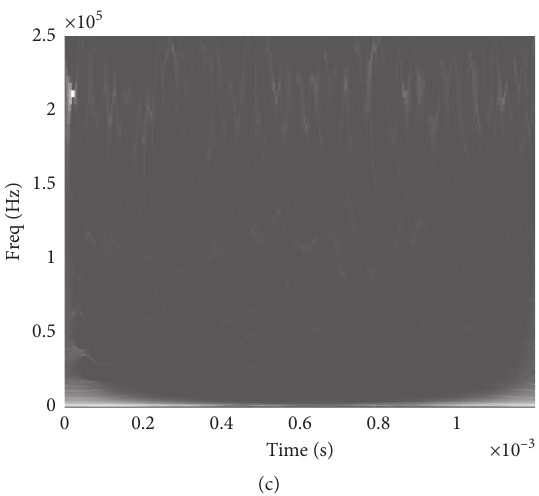
Figure 7: TFR obtained using the SST method: (a) PEC signal; (b) TFR; (c) gray image.